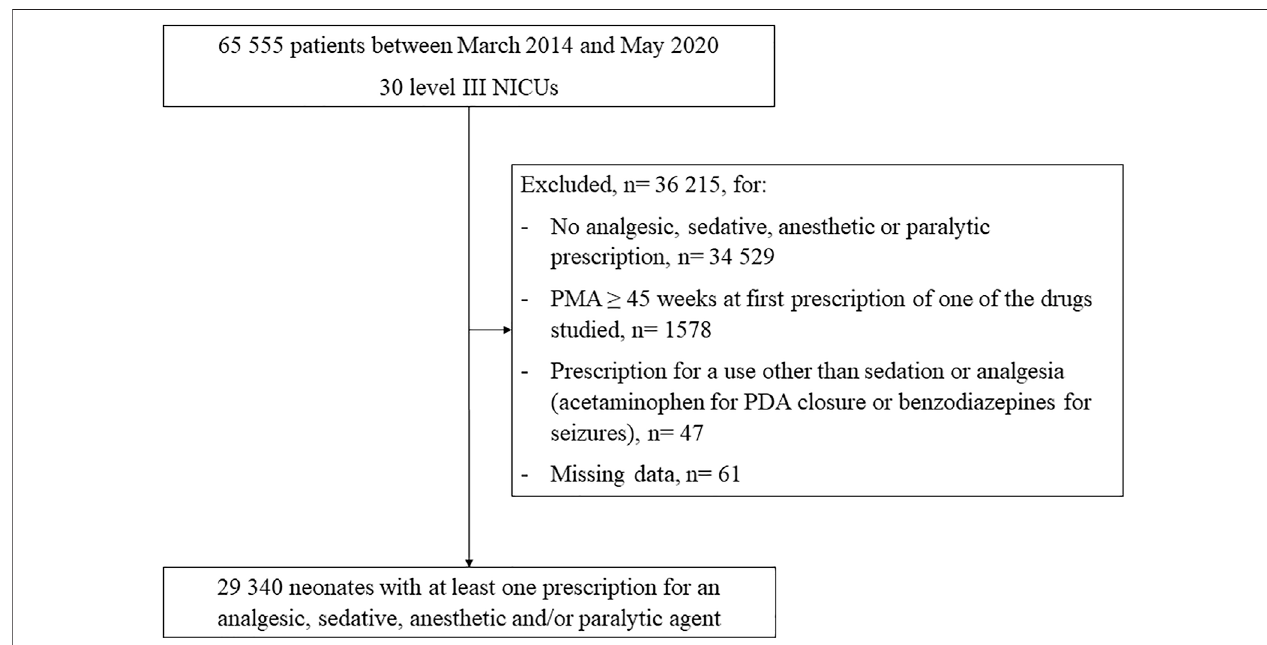
FIGURE 1 | Population fl ow chart Abbreviations: PMA, post-menstrual age (weeks); PDA, patent ductus arteriosus; NICU, neonatal intensive care unit.